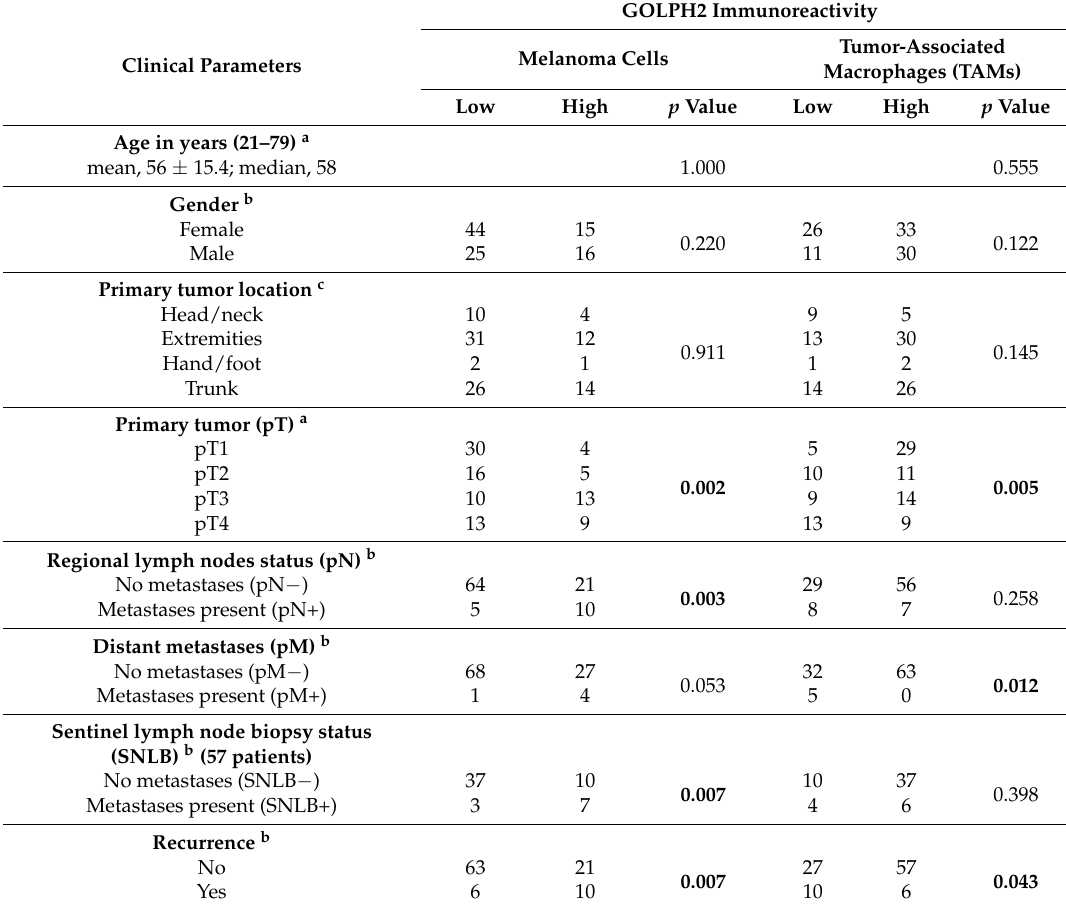
Table 1. Correlations between GOLPH2 immunoreactivity in melanoma cells and tumor-associated macrophages, and clinical